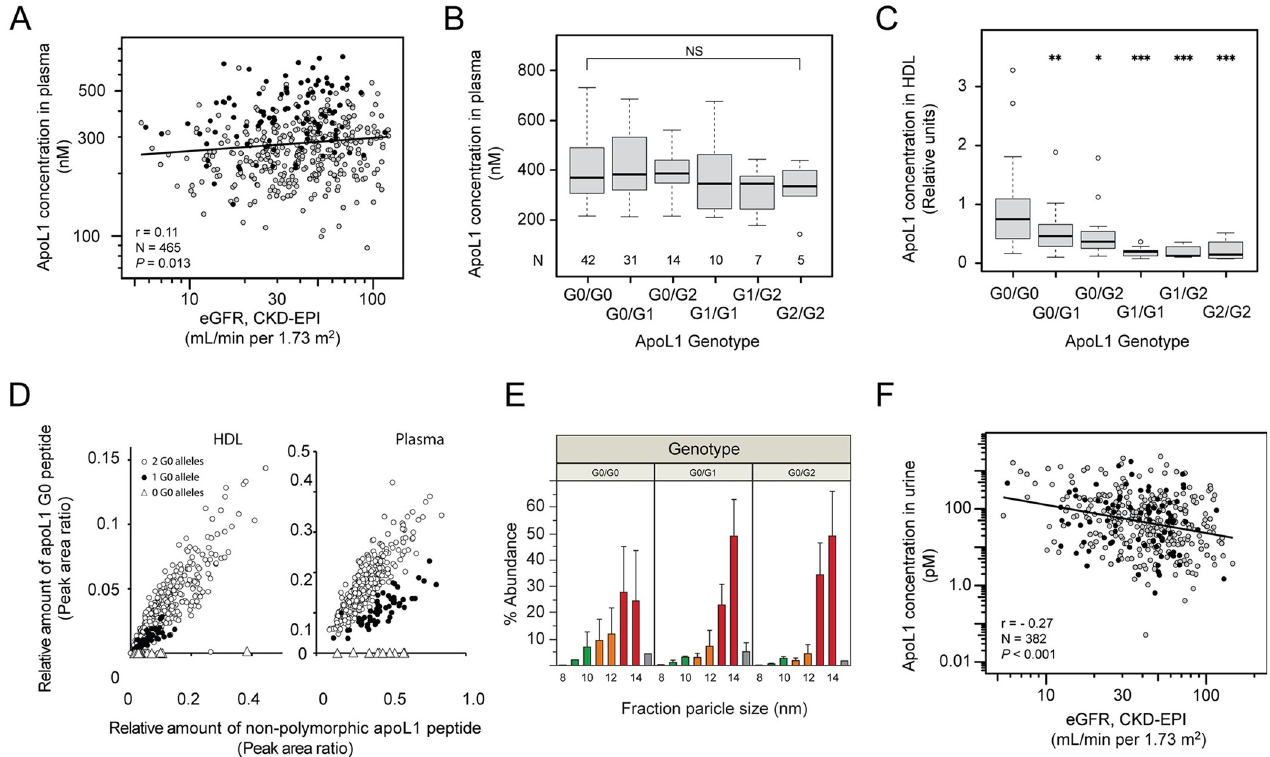
Fig 1. APOL1 in human plasma and urine. (A) The concentration of APOL1 in plasma (nM, determined by LC-MS/MS) is correlated with eGFR (mL/min/ 1.73 m 2 , calculated by the CKD-EPI 2021 equation). Black participants are represented with solid black circles and non-Black participants are represented with gray circles. A total of 465 participants had plasma for APOL1 analysis and eGFR from the same baseline study visit. The Pearson correlation coefficient for the entire cohort is shown. Statistical significance was determined by linear regression of the log-log transformed data. (B) The total concentration of APOL1 in plasma is shown for each APOL1 genotype in self-described Black participants. The number of participants (N) with each genotype is listed. (C) The relative concentration of APOL1 in the HDL fraction of plasma is shown for each APOL1 genotype in self-described Black participants. Statistical significance for each genotype vs. G0/G0 was assessed using Student’s t-test. � P < 0.05, �� P < 0.01, ��� P < 0.001. (D) Risk variant APOL1 causes co-expressed APOL1-G0 to shift out of the HDL fraction of plasma. The relative amount of G0-specific peptide ( i . e ., the peptide that has a different amino acid sequence in each of APOL1-G0, APOL1-G1, and APOL1-G2) is plotted vs. a non-polymorphic APOL1 peptide from a different region of the protein for individuals who were heterozygous for risk variant APOL1 alleles (closed circles), homozygous for APOL1 -G0 (open circles), or homozygous for risk variant alleles (open triangles). (E) Lipoprotein particles in plasma were separated using asymmetric flow field-flow fractionation and analyzed using LC-MS/MS. The relative amount of APOL1 protein in each fraction (%) is shown as mean ± SD. Bars are shaded different colors in order to more conveniently compare size fractions across genotypes. The data for the G0/G0 genotype are derived from samples from an equal number of Black and non-Black participants. All heterozygous participants self-described as Black race. (F) The amount of APOL1 in urine is negatively correlated with eGFR. The concentration of APOL1 in urine was measured using LC-MS/MS. Black participants are represented with solid black circles and non-Black participants are represented with gray circles. There were 382 participants in SKS with urine available for APOL1 analysis who also had eGFR measured at the same baseline study visit. The Pearson correlation coefficient is shown. Statistical significance was determined by linear regression of the log-log transformed